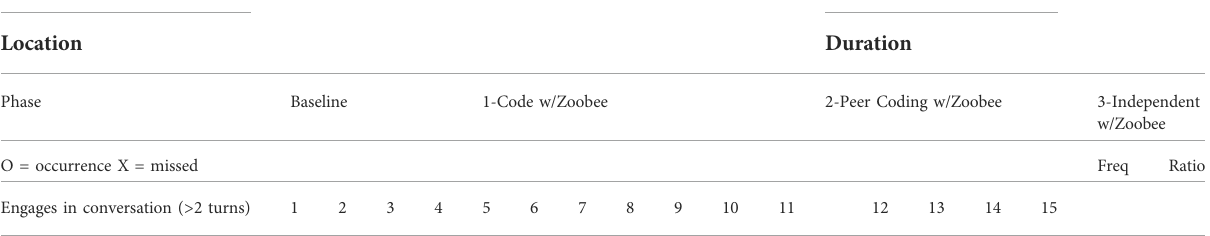
TABLE 1 Verbal reciprocity coding.